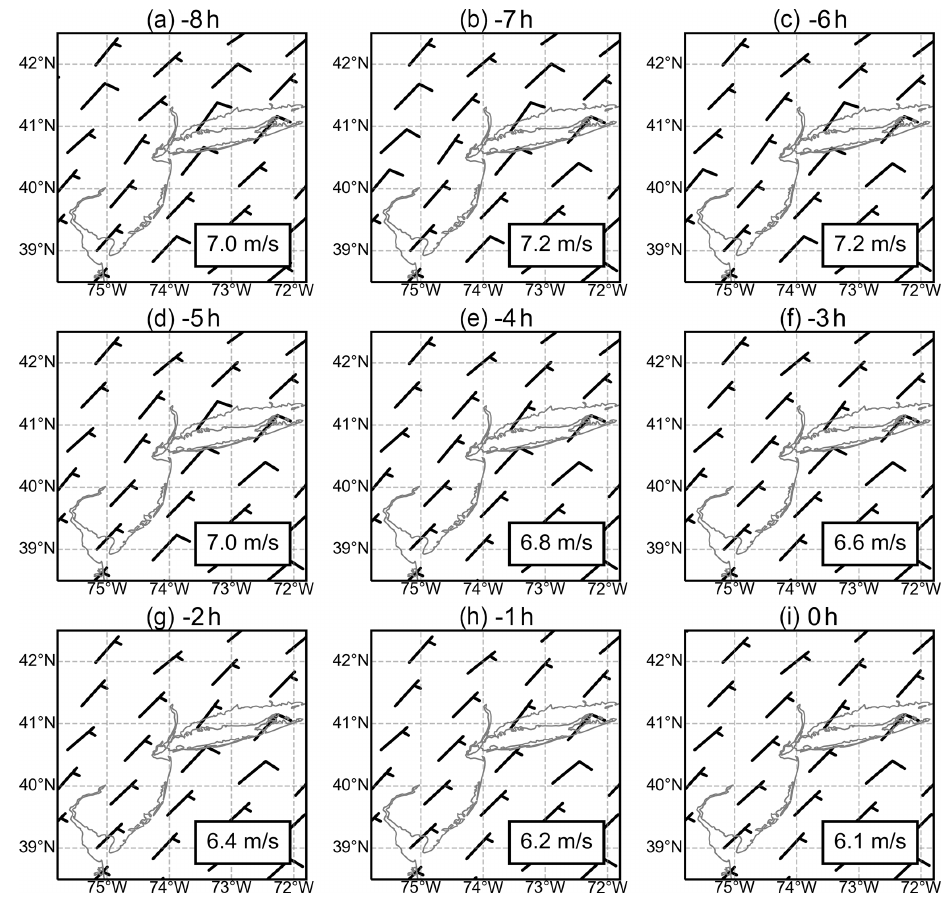
Figure 5. Wind barbs around New York City for different times of the day. All northeasterly winds at 14:00LT from April to September of 2016 are averaged and shown in (i) . Wind barbs for the northeasterly winds backward trajectories from 8 to 1h prior to 14:00LT are displayed in (a–h) . Wind speed is given in units of knots, which is equivalent to nautical miles per hour (1.9kmh − 1 ). Each short and long barb represents 5 knots (9.3kmh − 1 ) and 10 knots (18.5kmh − 1 ), respectively. The average wind speed is displayed in the grey